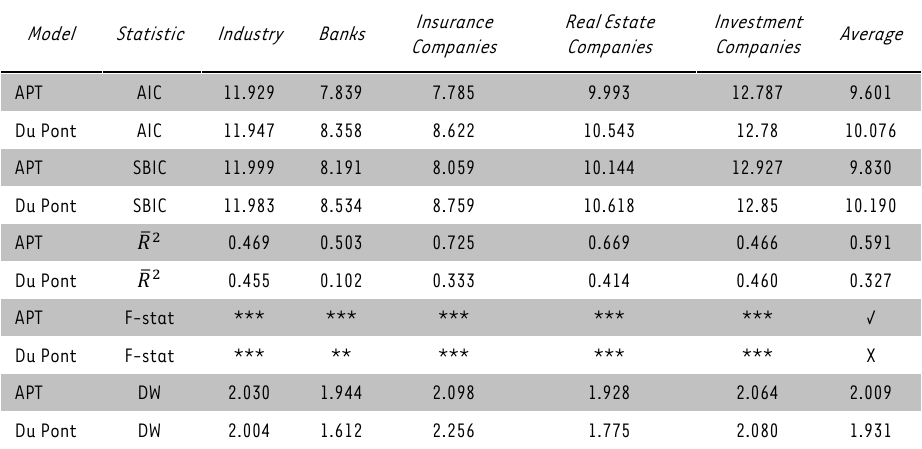
DuPont model versus APT